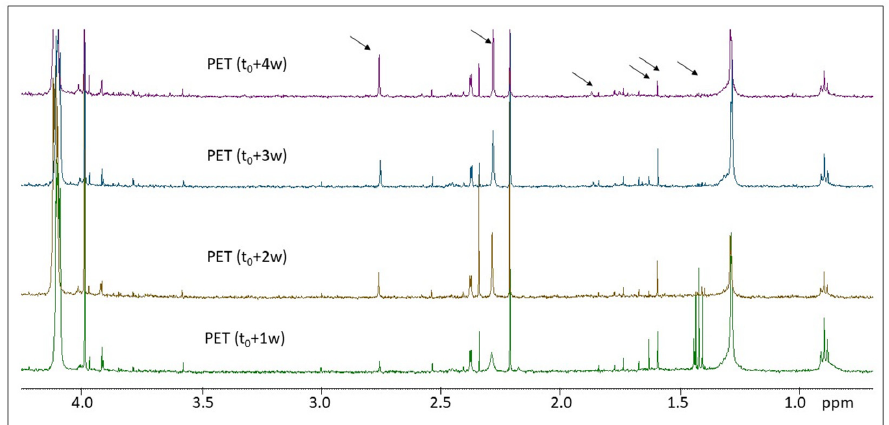
Figure 5. Stackplot of the 1 H NMR spectra of the PET microplastics at different times of irradiation (from bottom to top): t 0 + 1 w, t 0 + 2 w, t 0 + 3 w, and t 0 + 4 w, enlarged at the spectral baseline in the region between 0.6 and 4.3 ppm. Spectra were normalized with respect to the aromatic signal centered at 8.11 ppm due to the aromatic moiety of PET. Dark arrows indicate the most significant signals appearing or disappearing as a result of degradation.